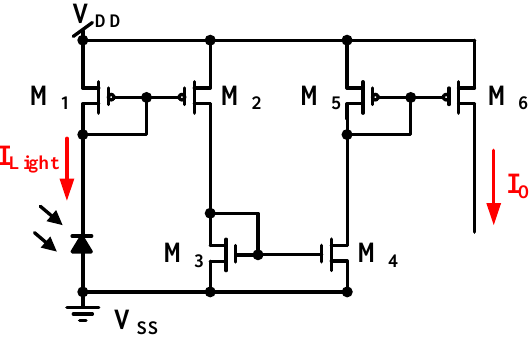
Figure 5. CA without dark current cancellation.